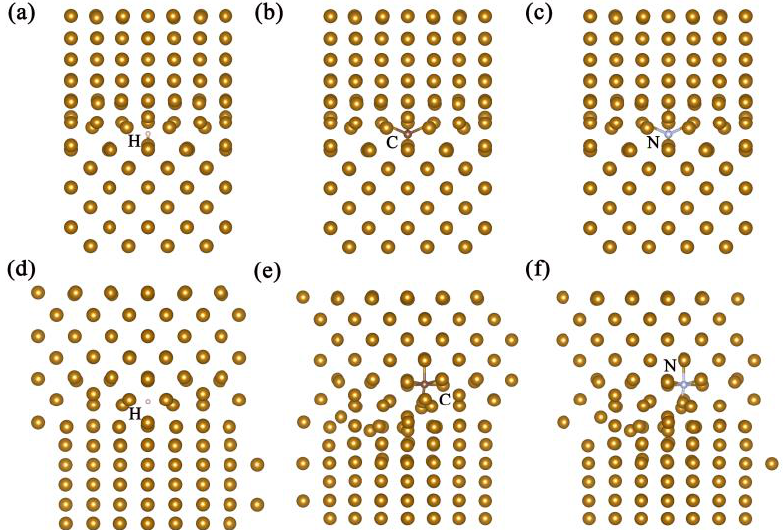
Figure 2. Model diagram before and after optimization. ( a – c ) The view of the presence of a H/C/N atom at the interface before optimization, respectively. ( d – f ) The view of the presence of a H/C/N atom at the interface after optimization,